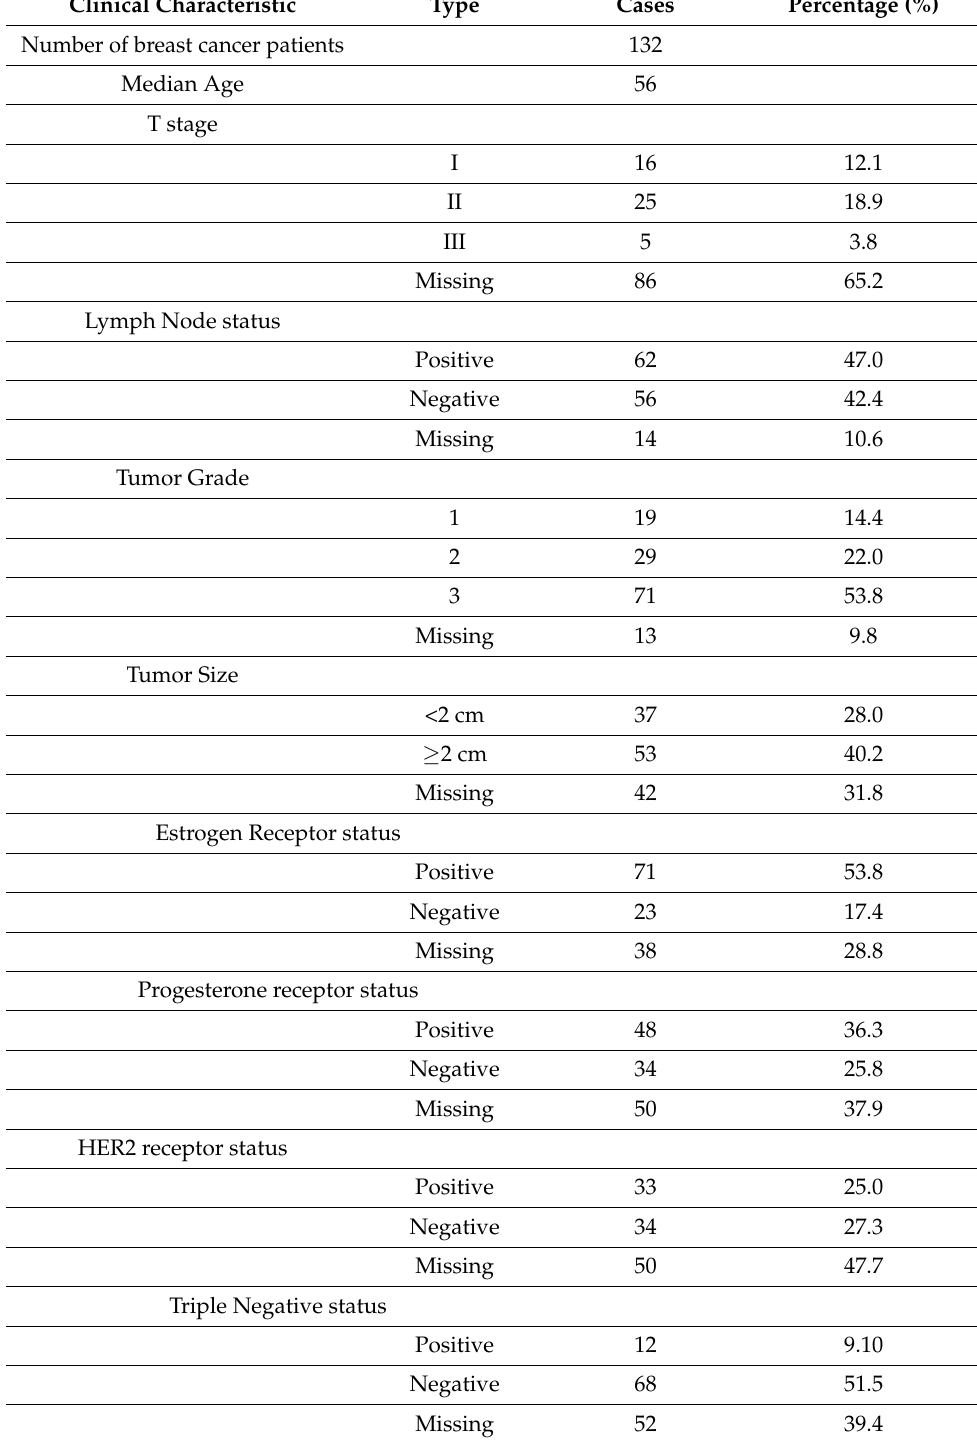
Table 1. Clinical characterization of all breast cancer patients in the current